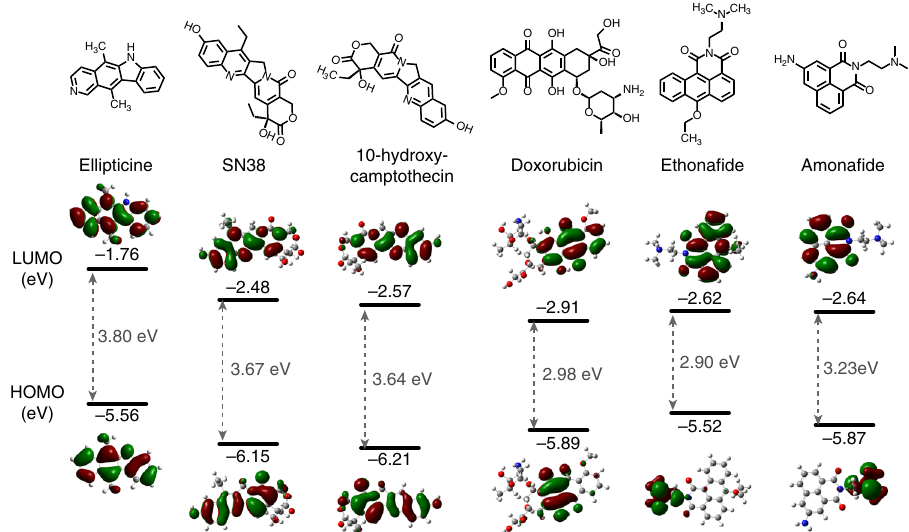
Fig. 1 Molecular and electronic structures of DNA topoisomerase inhibitors tested. The top row shows the molecular structures of selected compounds possessing planar conjugated segments and hydrogen-bonding moieties (amine, amide, carbonyl, ester, ether, hydroxyl etc.) The bottom row shows corresponding optimized frontier orbitals and schematic energy level diagram of anticancer drugs as calculated using the B3LYP functional and 6 – 311 + G(d,p) basis